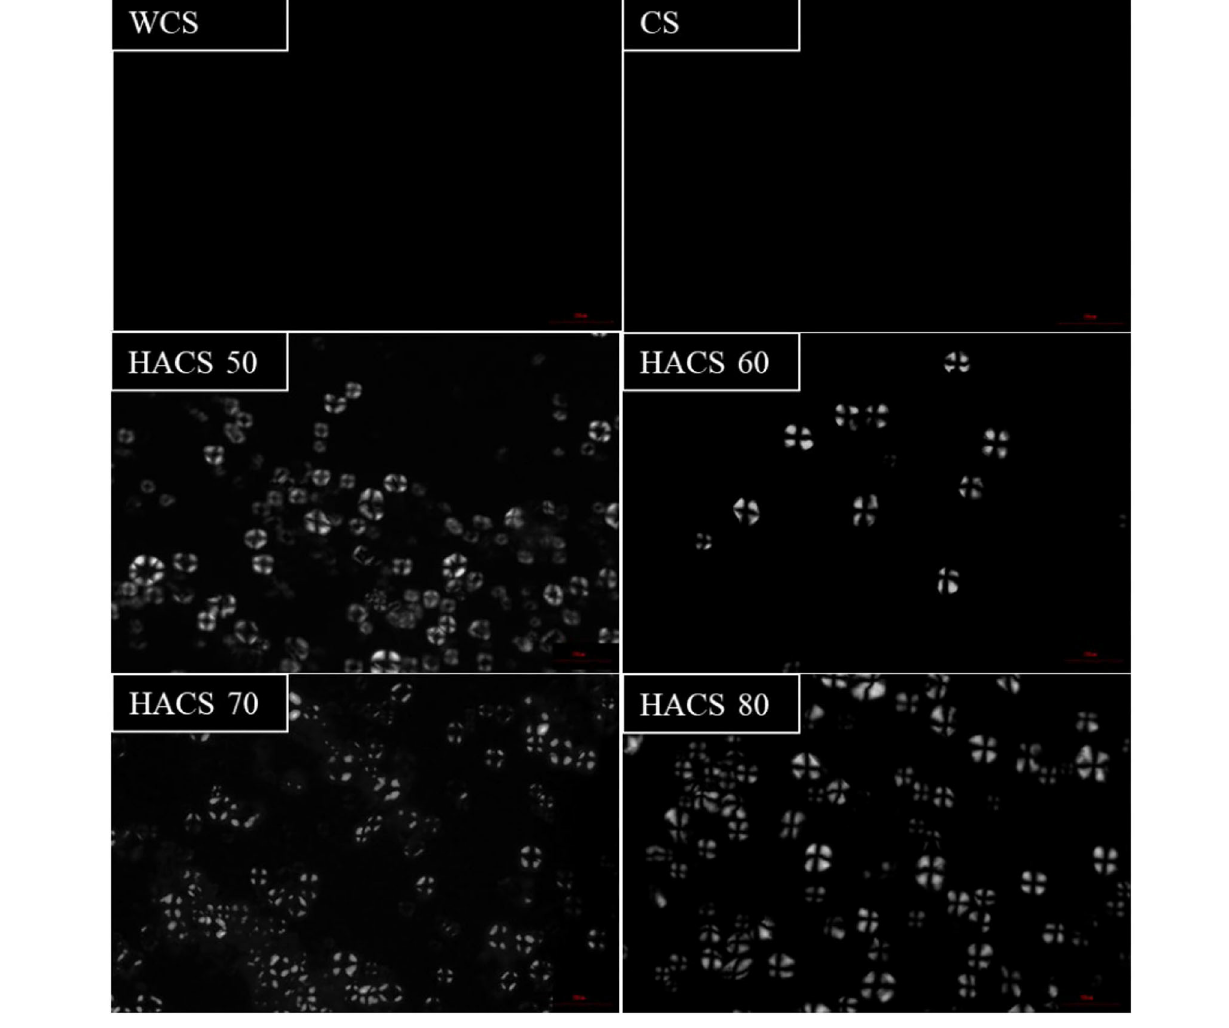
Frontiers in Nutrition |